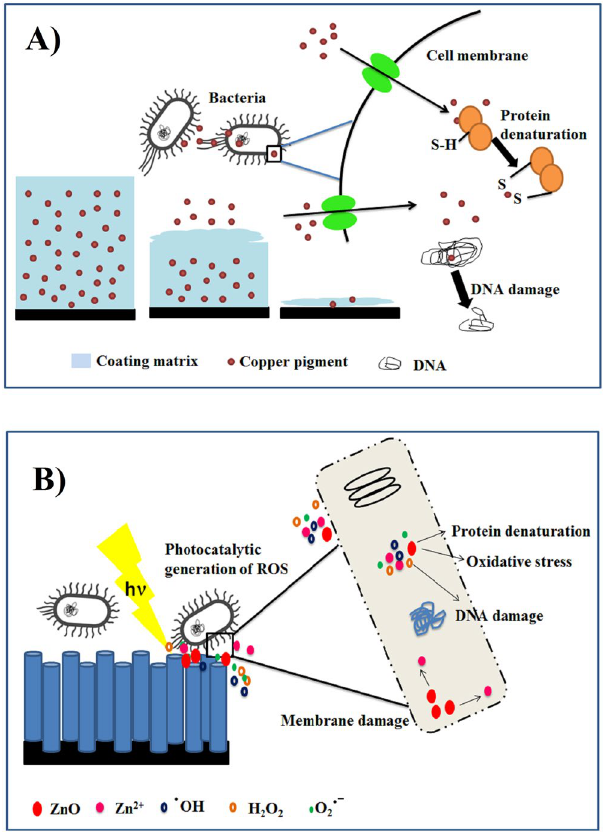
Figure 6. Schematic representation for mechanism of action. Schematic representation for mechanism of antifouling action for ( A ) copper based antifouling paint ( B ) for zinc oxide nanorod coated